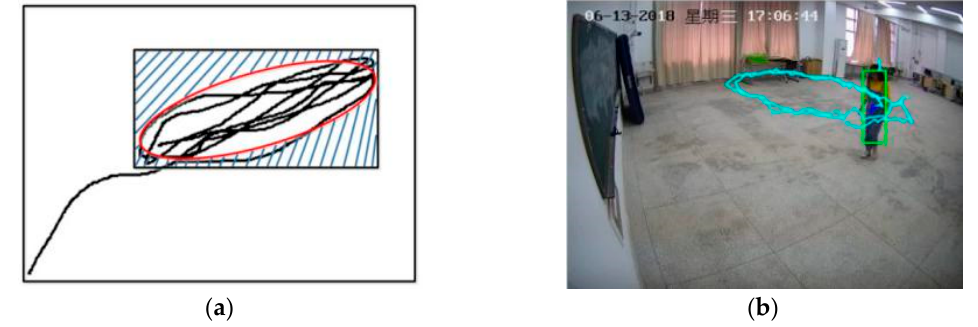
Figure 3. Ellipse loitering. ( a ) The ellipse detection method and rectangle detection method fitting the trajectory of simulation. ( b ) Ellipse loitering in real scene.